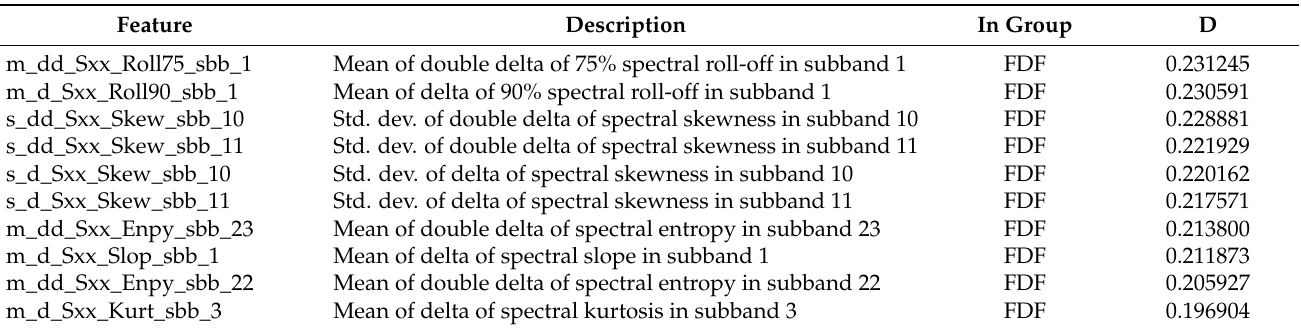
Table 7. Top 10 selected features using the proposed KS-based algorithm–RODeCAR.